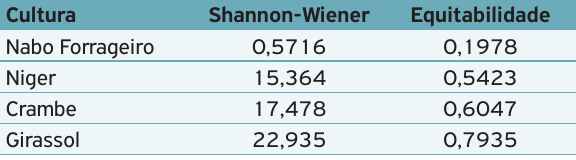
Tabela 3. Índices de diversidade de Shannon-Wiener e equita- bilidade calculados para cada cultura em Dourados (MS),